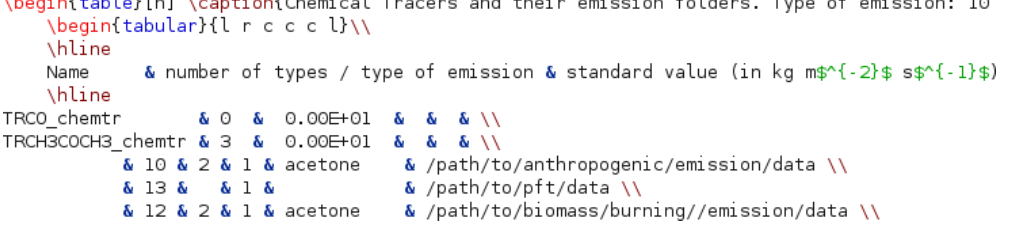
Figure 3. Sample extract of a LaTeX table committing emission metadata to the module. Please note that the header lines are cut. For details of the table content see text.